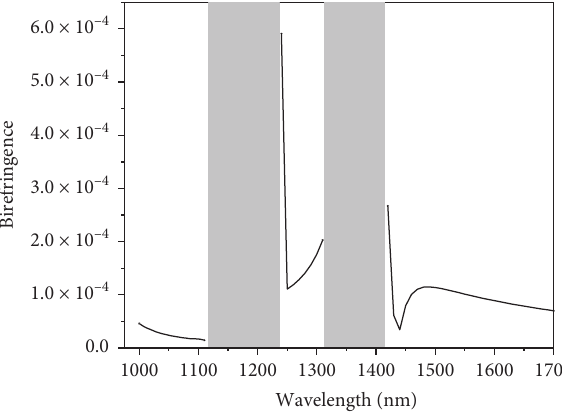
Figure 4: Birefringence as a function of